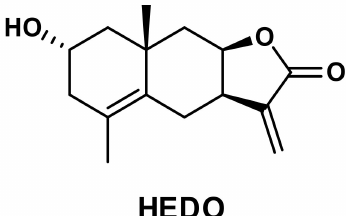
Figure 1. Chemical structure of 2 α -Hydroxyeudesma-4,11(13)-dien-8 β ,12-olide (HEDO) isolated from I. britannica flowers.